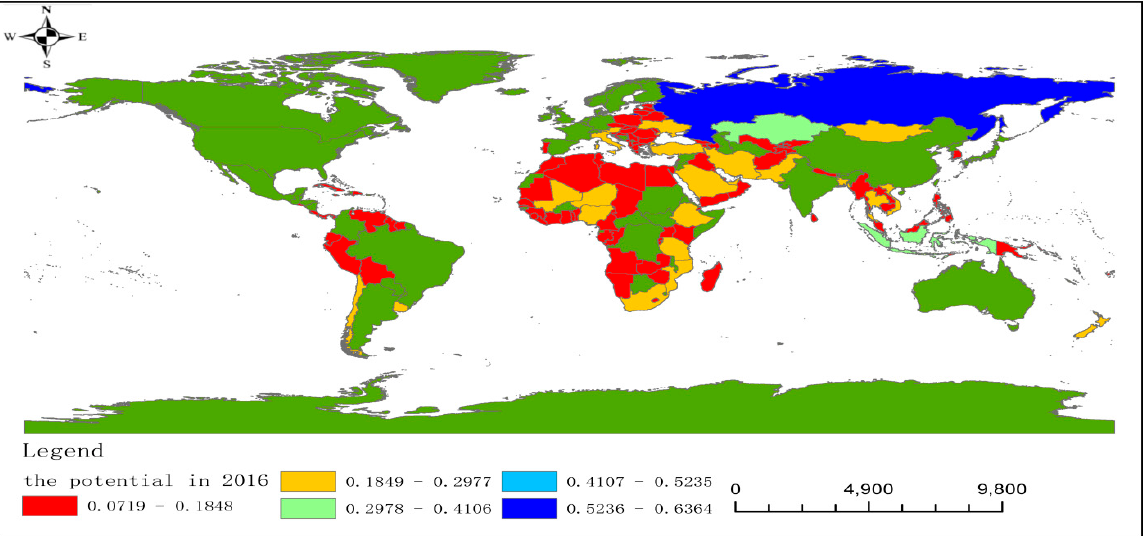
Figure 8. Distribution of arable land investment potential in the “the belt and road initiative” countries in 2016.